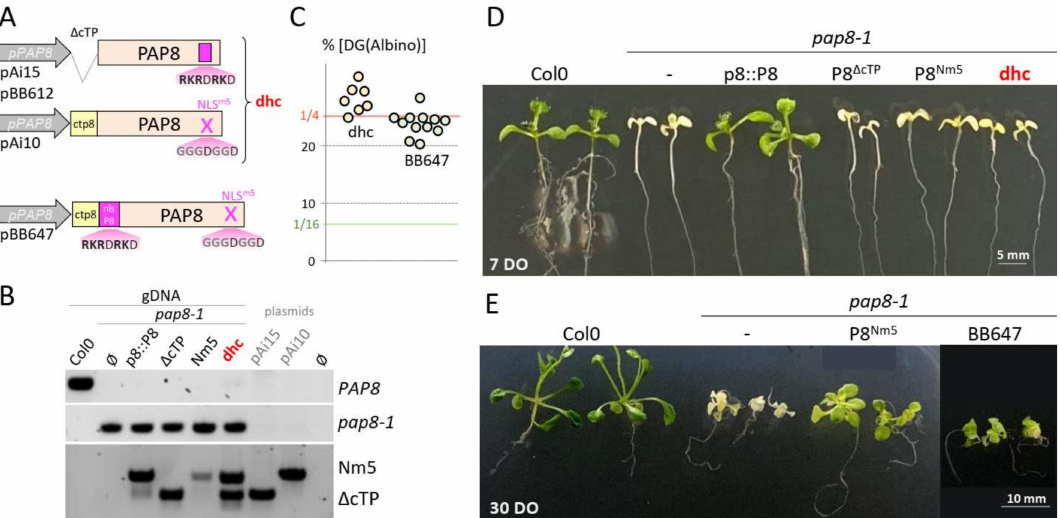
Figure 3. The region with the predicted NLS provides functions in addition to the nuclear localization signal. ( A ) Schematic illustration of the different PAP8 recombinant genes. cTP, chloroplast transit peptide; NLS, nuclear localization signal; m5, five substitutions leading to amino acid changes of K and R in G; dhc, double hemi-complementation test. ( B ) PCR-based genotyping of the different lines showing in particular that dhc possess the two constructions (Nm5 and ∆ cTP). ( C ) Dot plot of the percentage of the delayed greening phenotype obtained in the segregating offspring from the doubly heterozygous plants from dhc (light orange dots) or independent T1 for BB647 (light green dots). A ratio of 1/4 (25%) corresponds to absence of genetic interaction between the trans- gene and the pap8-1 allele: no complementation. ( ε -test, α = 0.05; Fisher Yates) dhc #04: